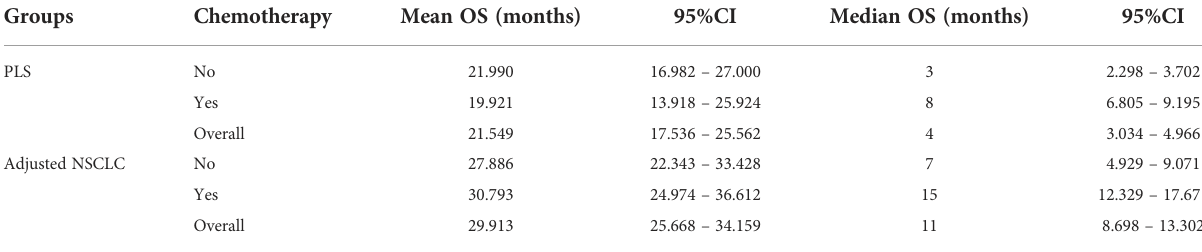
TABLE 5 Comparison of mean and median survival time after adjuvant chemotherapy between the PSC and NSCLC cohorts.